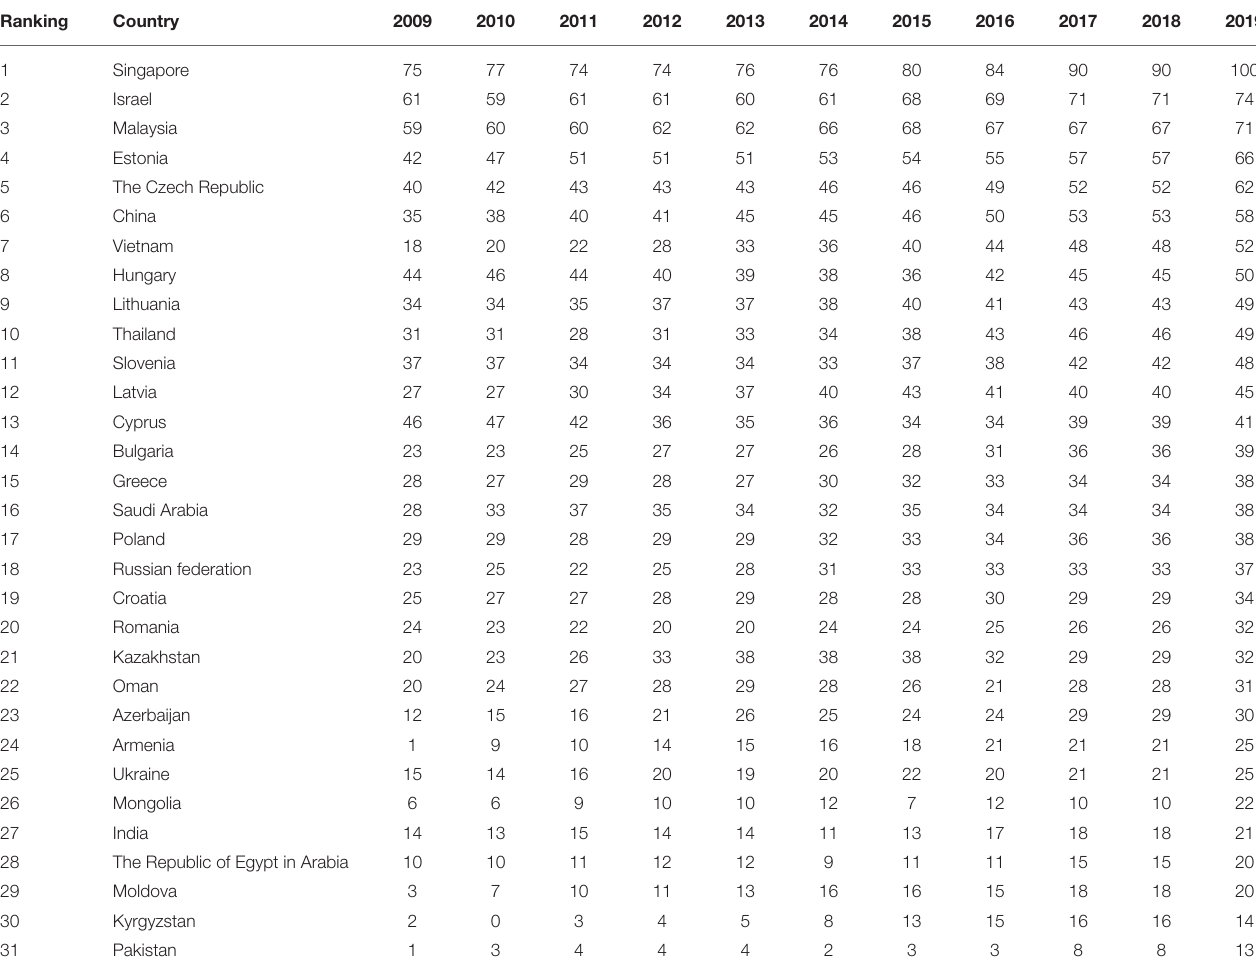
TABLE 3 | Comprehensive scores of digital economic development indicators of countries along the “Belt and Road” from 2009 to 2019.